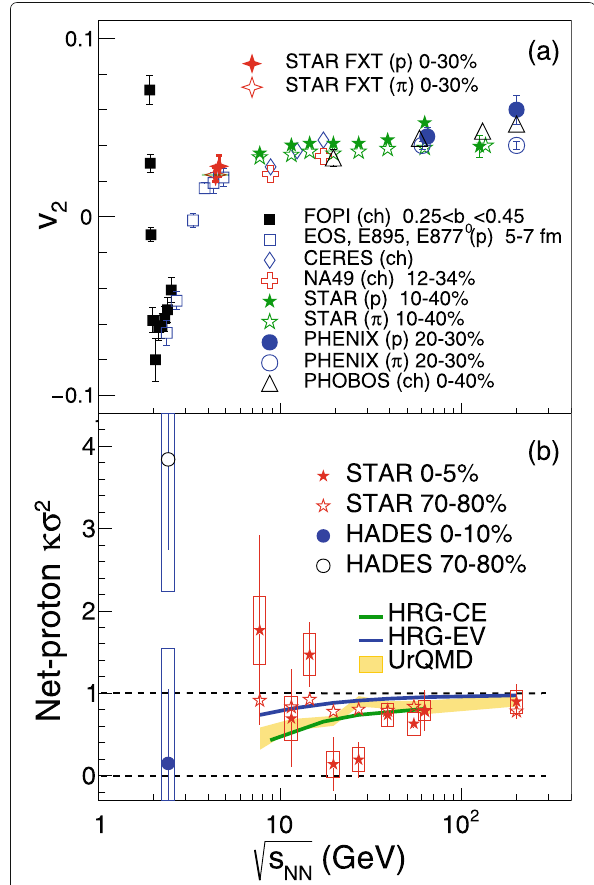
Fig. 16 Collision energy dependence of ( a ) elliptic flow v 2 [123] (see Ref. [123] and references therein for details) and ( b ) 4th-order cumulant ratio of net-proton distribution κσ 2 [124,